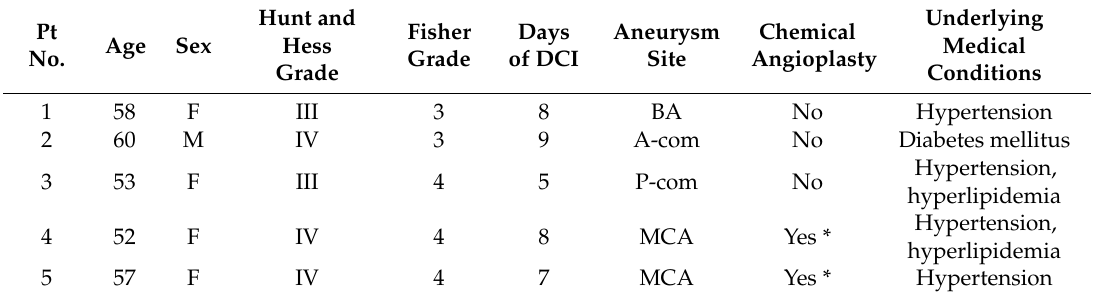
Table 1. Baseline characteristics of the enrolled patients. All patients underwent coil embolization within 6 h after the onset of subarachnoid